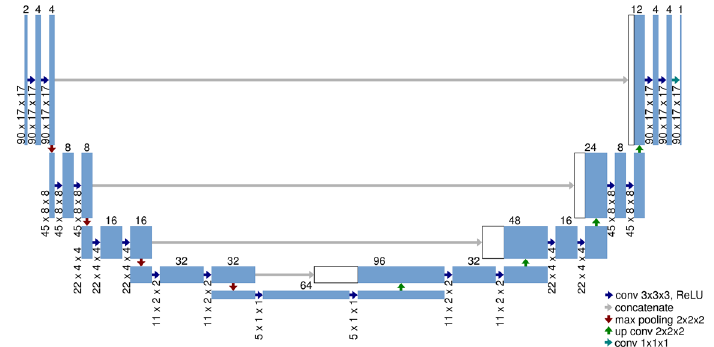
Figure 2. Architecture of the standard implementation of the U-Net.